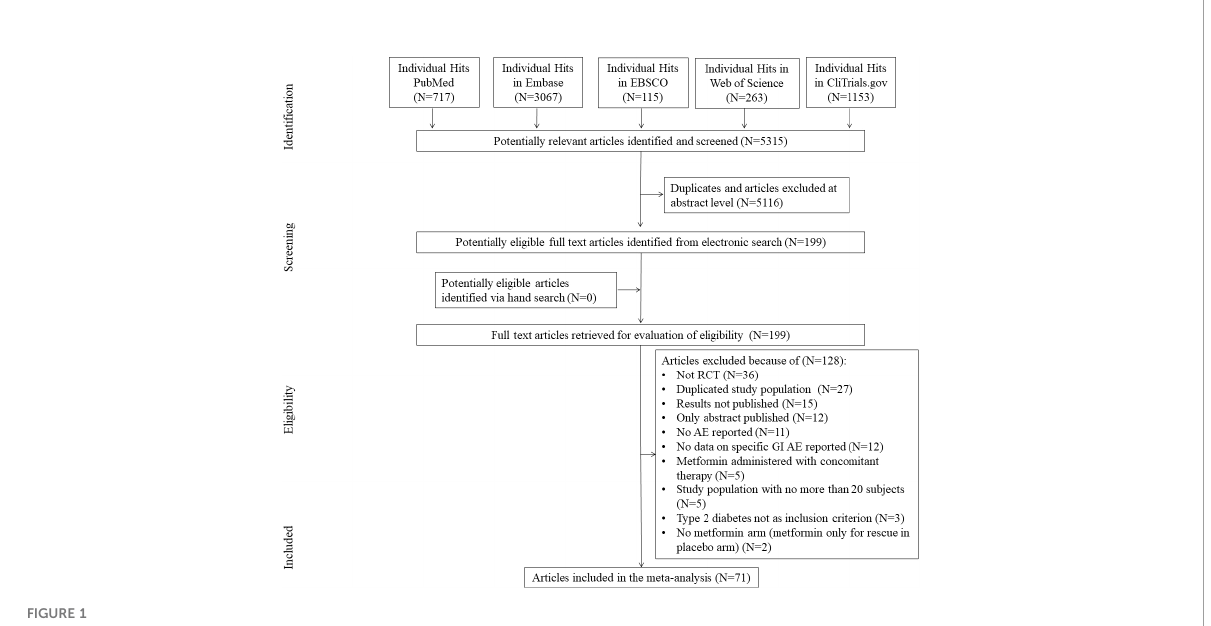
FIGURE 1 Study fl ow